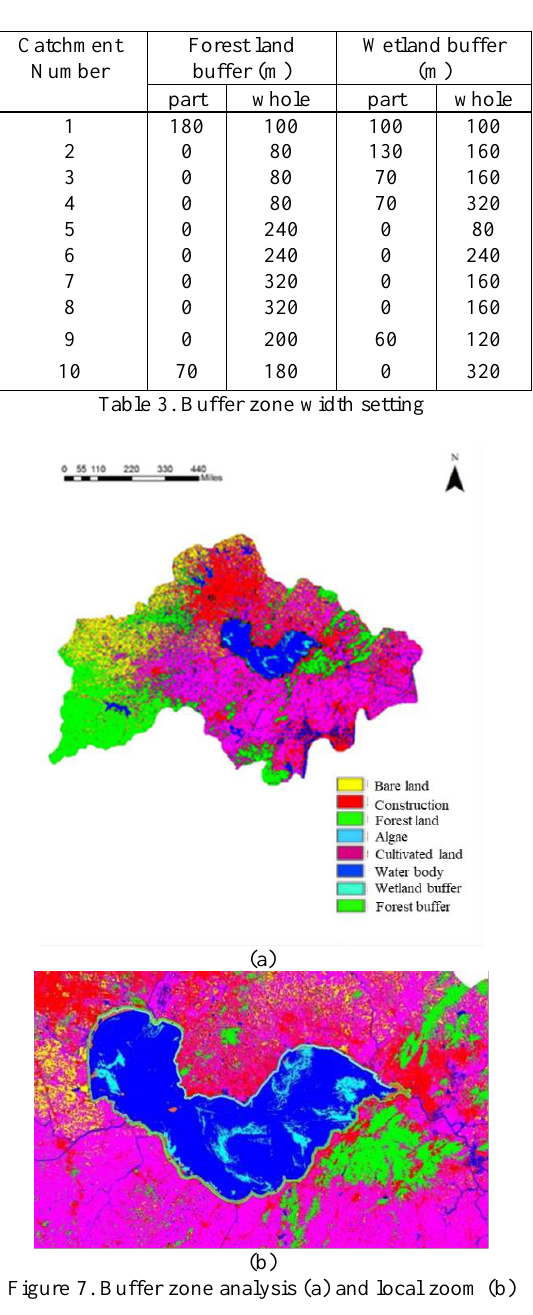
Figure 7. Buffer zone analysis (a) and local zoom